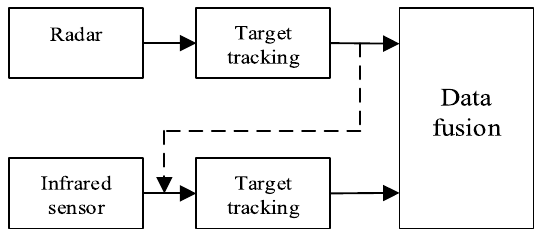
Figure 1. Traditional distributed fusion model for single target tracking.